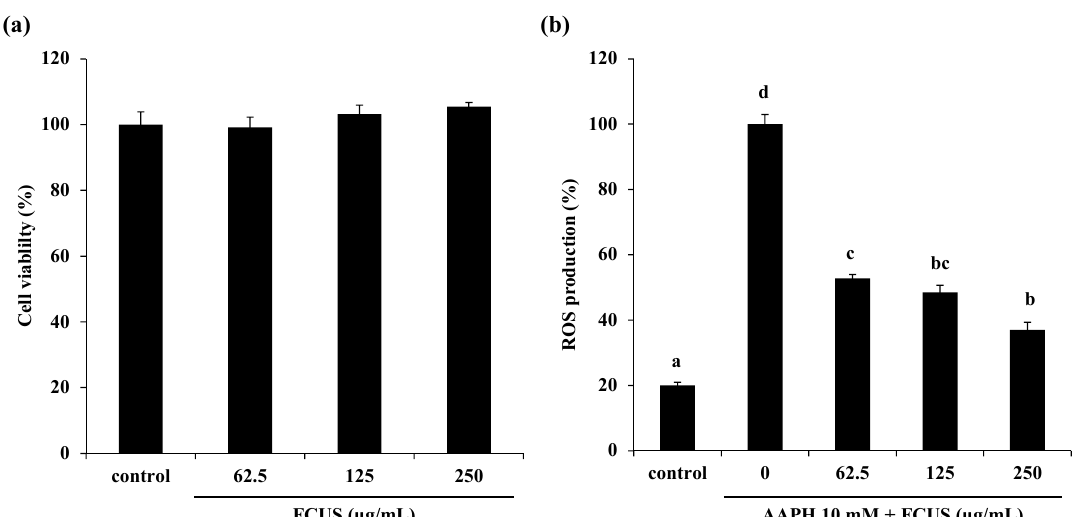
Figure 2. Cytotoxicity ( a ) and intracellular reactive oxygen species (ROS) scavenging activity ( b ) of FCUS in Vero cells. Each value is expressed as the mean ± SE. a–d Means not sharing a common letter are significantly different between groups ( p < 0.05).